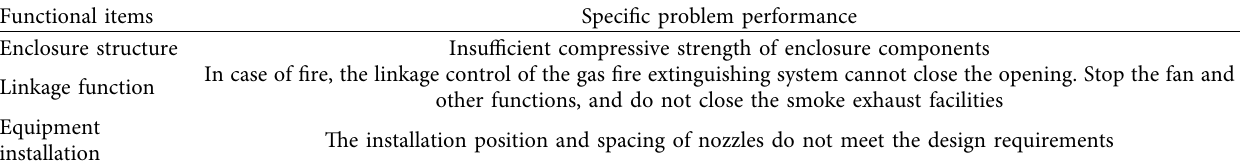
Table 9: Te problem of the fre-extinguishing gas system (source: author).